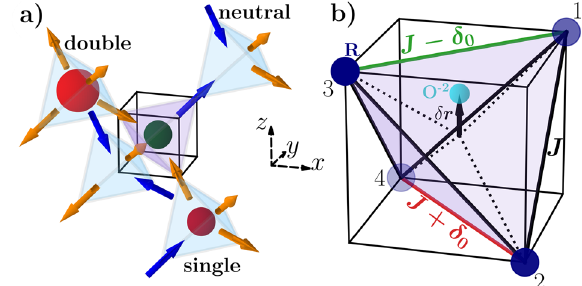
Fig. 1 Structure, magnetic monopoles and O − 2 distortions. a In the oxide pyrochlore structure the Ising spins (coloured arrows) occupy the shared vertices of tetrahedra, pointing either towards or away from their centre.